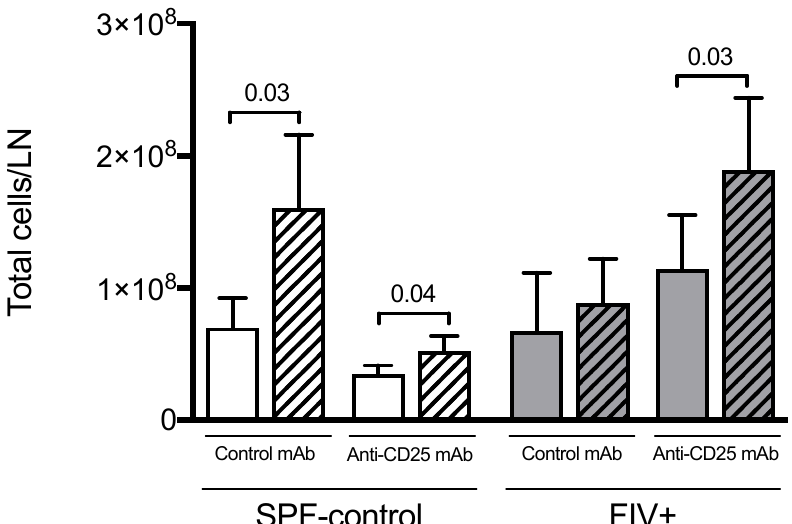
Figure 2. The effect of Treg depletion on total LN cellularity. The total number of cells per control lymph node (open bars) versus Lm-draining lymph node (hatched bars) was determined for SPF-control and FIV-infected cats treated with isotype control mAb or anti-CD25 mAb. Statistical analysis was performed using Mann–Whitney U test; n = 6 for each treatment group; p -values are shown above brackets that indicate group comparisons.